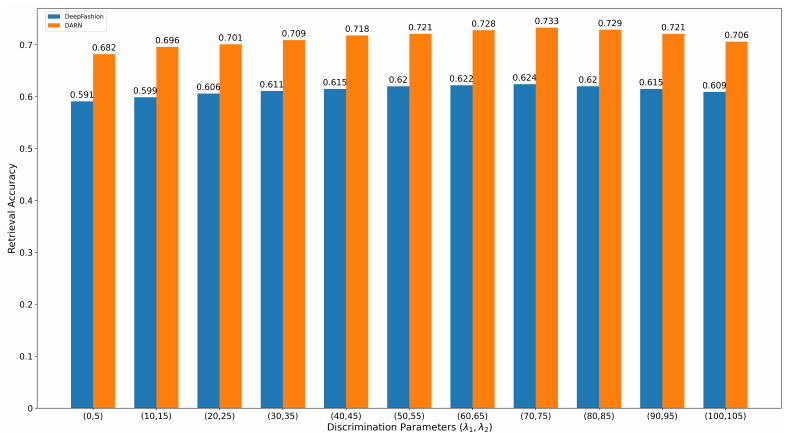
Figure 8. The retrieval performance of Discriminative Loss Margin with different discrimination parameters λ 1 and λ 2 in Consumer-to-Shop Clothes Retrieval